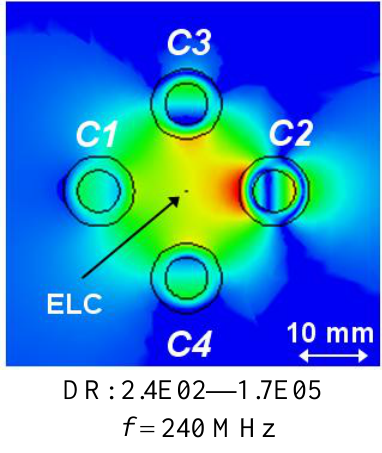
Figure 8. The magnitude of the electric field of the 4-cylinder structure for the separation distance d = 30 mm and 240  f MHz; this is the frequency at which the first resonance d   , and the electric appears in Figure 6. The ELC is located at )0,mm2/(),( o 1, Coss field is depicted in the xy -plane with the linear dynamic range (DR) in V/m indicated below the figure. Curves representing the circular surfaces of the structure and a left-right arrow, indicating the size scale of the figure, are likewise indicated.